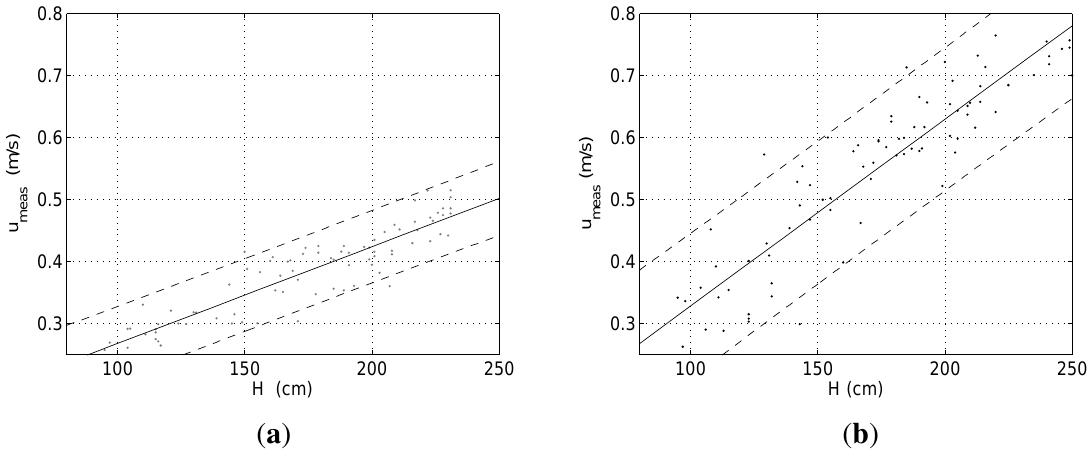
, with the tidal range, H , for spring, mean meas